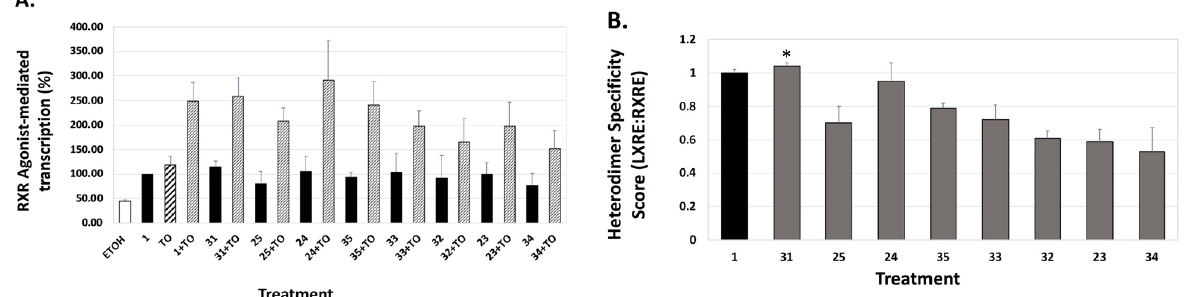
Figure 7. RXR agonist potentiation of LXRE-regulated transactivation with or without the T0901317 LXR agonist. ( A ) U87 glial cells were transfected with an expression vector for human LXR α , an LXRE-luciferase reporter gene with three tandem copies of the LXRE from the human ApoE gene, and a Renilla control plasmid. Cells were transfected for 24 h utilizing a liposome-mediated transfection protocol and then treated with ethanol vehicle, or 100 nM of the indicated compound alone or in combination with 100 nM TO901317 (TO). LXRE-directed activity was compared to compound 1 (Bexarotene), set to 100%. ( B ) The “Heterodimer Specificity Score” was determined by the LXRE:RXRE ratio with compound 1 set to 1.0. All error bars represent standard deviations; the data are representative of at least three independent experiments with six replicates in each treatment group. * p < 0.05 versus control compound 1 .